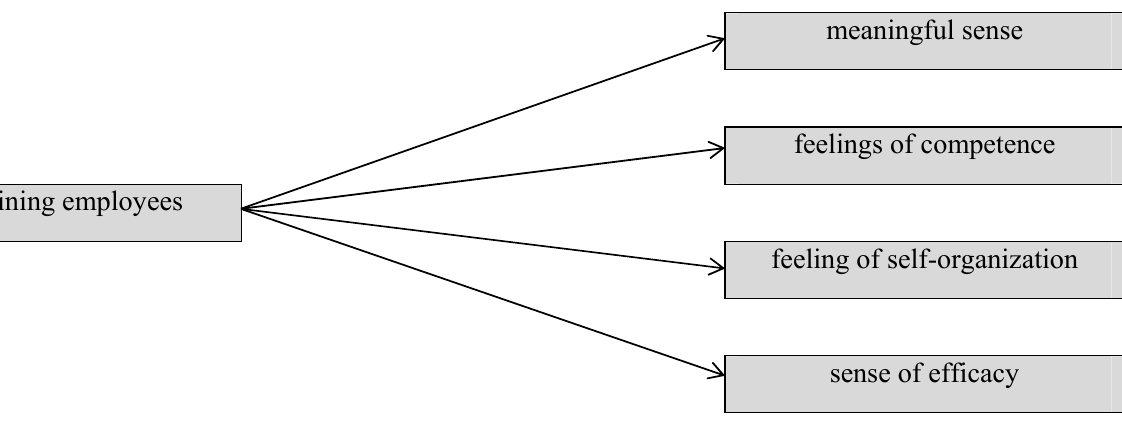
Fig. 1. The proposed